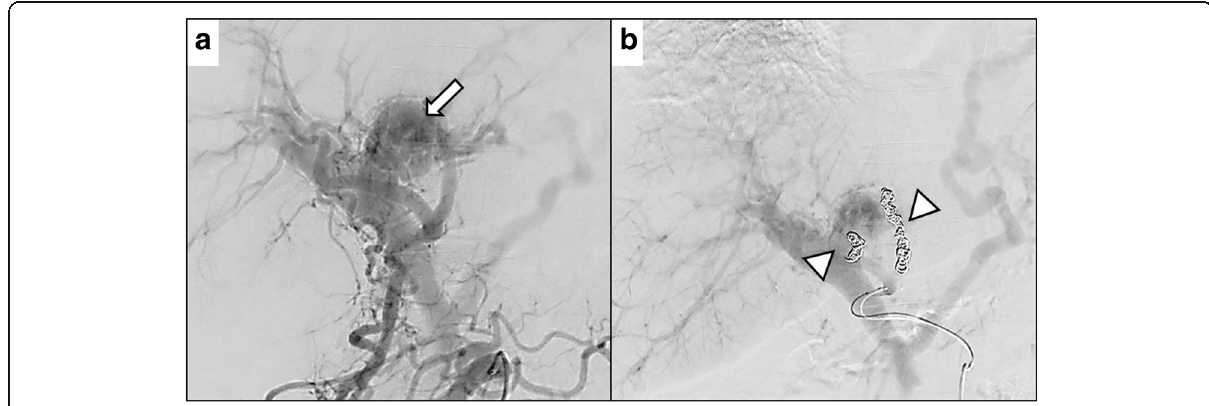
Fig. 3 Digital subtraction angiography findings. a Superior mesenteric arteriography reveals intrahepatic arterioportal fistula (arrow) and early filling of the left branch of the portal vein. b Proper hepatic angiography after coil embolization of the A2, A3, and A4 (arrowhead) also shows incomplete occlusion of the